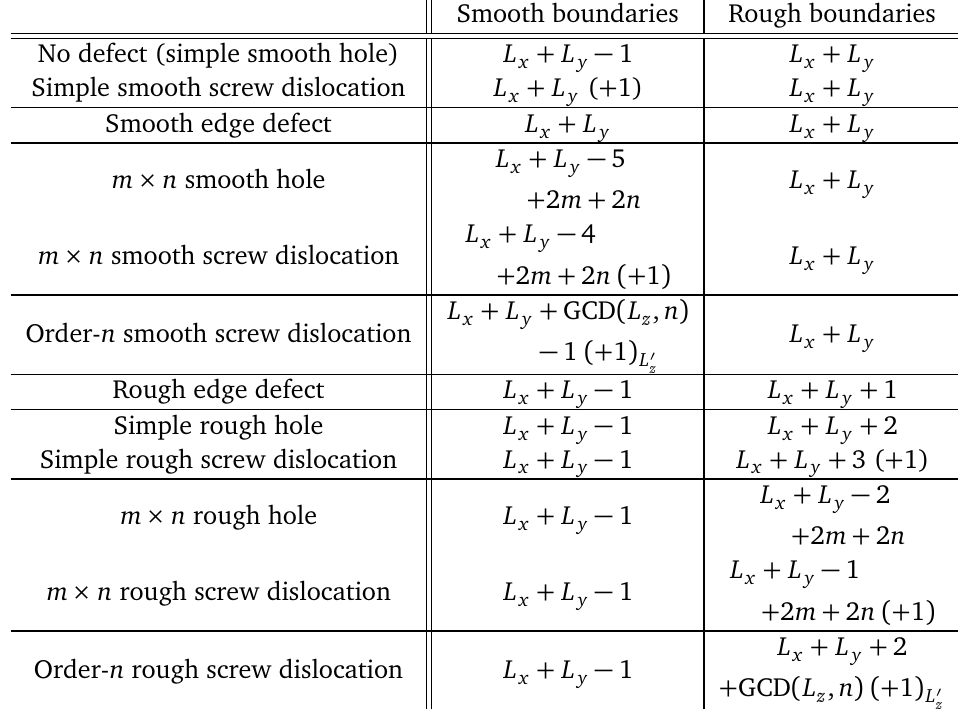
, while for even L there is one more logical z z to the suffix, z = L z GSD if L (cid:48) is 2 z GCD ( L z , n )